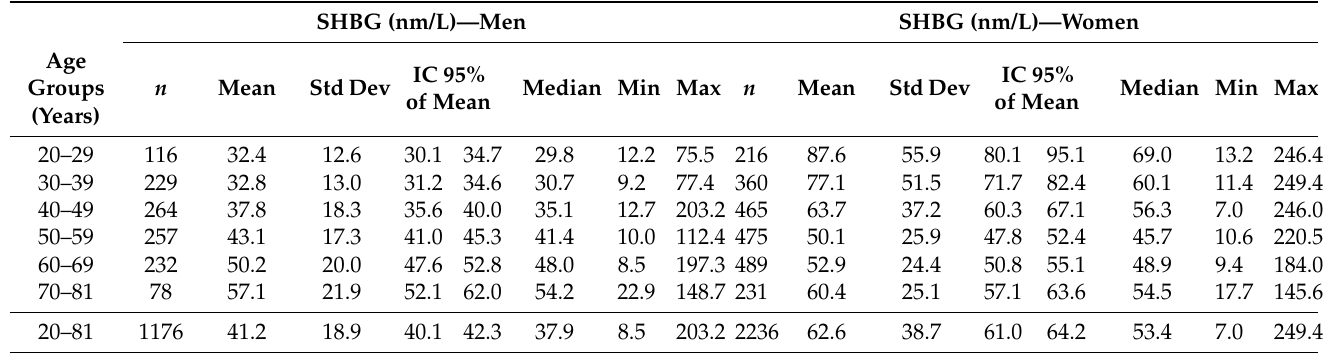
Table 1. Sex Hormone-Binding Globulin (SHBG) distribution by age groups and sex. The Malattie Aterosclerotiche Istituto Superiore di Sanit à (MATISS) study, men and women aged 20–81 years